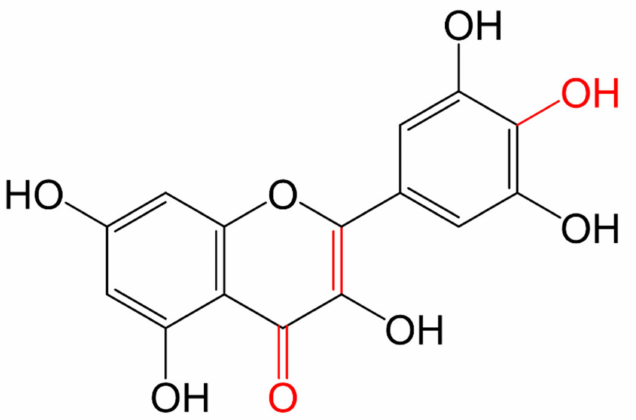
Figure 7. Structural requirements (marked in red) for lipoxygenase inhibition.